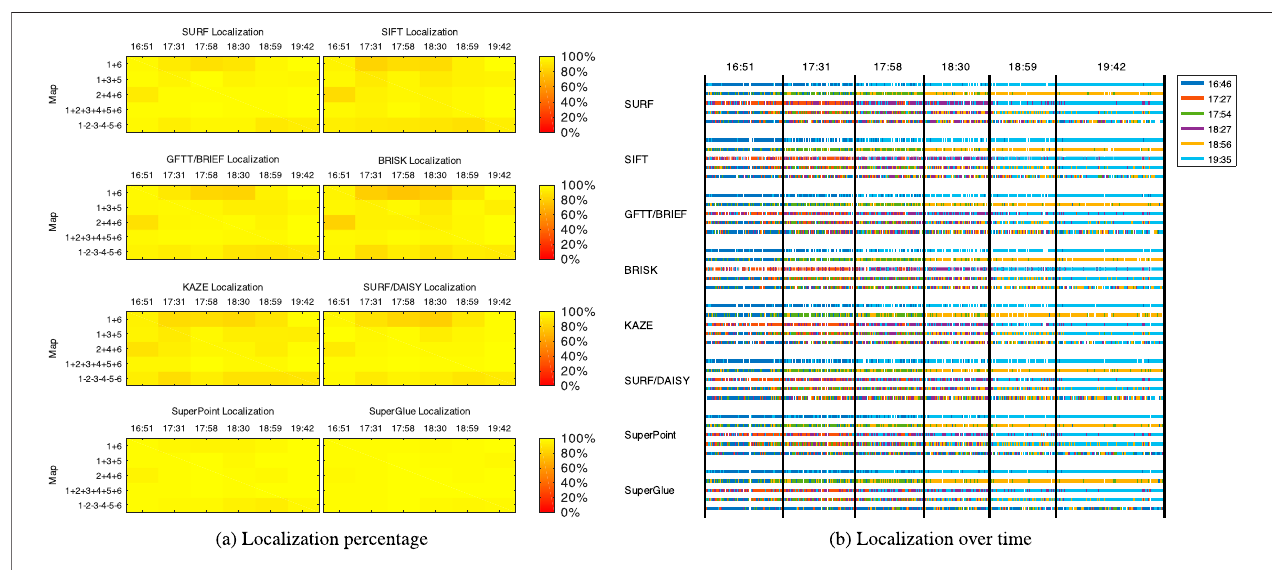
FIGURE5| Re-localizedframesovertimeoftheAtoFlocalizationsessions( x -axis)overthe fi vemulti-sessionmaps1+6,1+3+5,2+4+6,1+2+3+4+5+6,and1-2- 3-4-5-6 ( y -axis, ordered from top to bottom), in relation to the visual features used: (A) re-localization percentage; (B) re-localization over time.